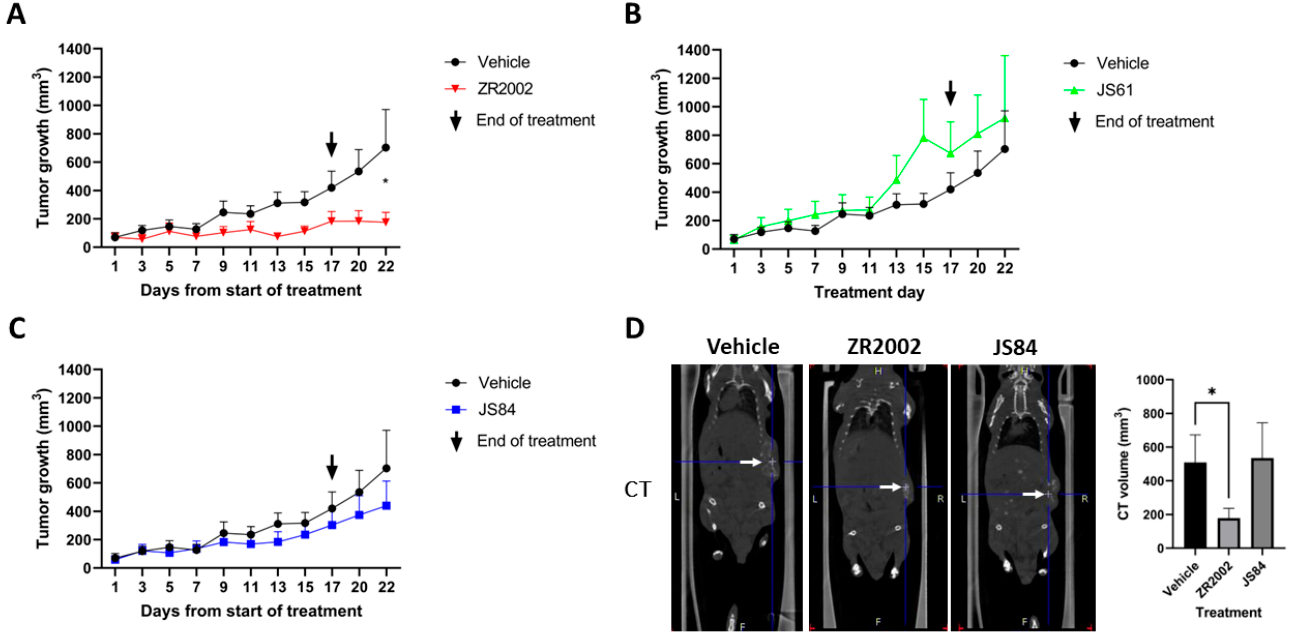
Figure 2. Antitumor activities of ZR2002, JS61 and JS84. Quantification of tumor growth measured with caliper in ( A ) ZR2002-treated group, ( B ) JS61-treated group and ( C ) JS84-treated group compared with vehicle group in each graph. ( D ) Representative coronary sections of CT images for ZR2002, JS84 or vehicle-treated mice (white arrows indicate the tumor) with CT tumor volume quantification on day 22. Data are expressed as means ± SEM. * p < 0.05 between the two groups.